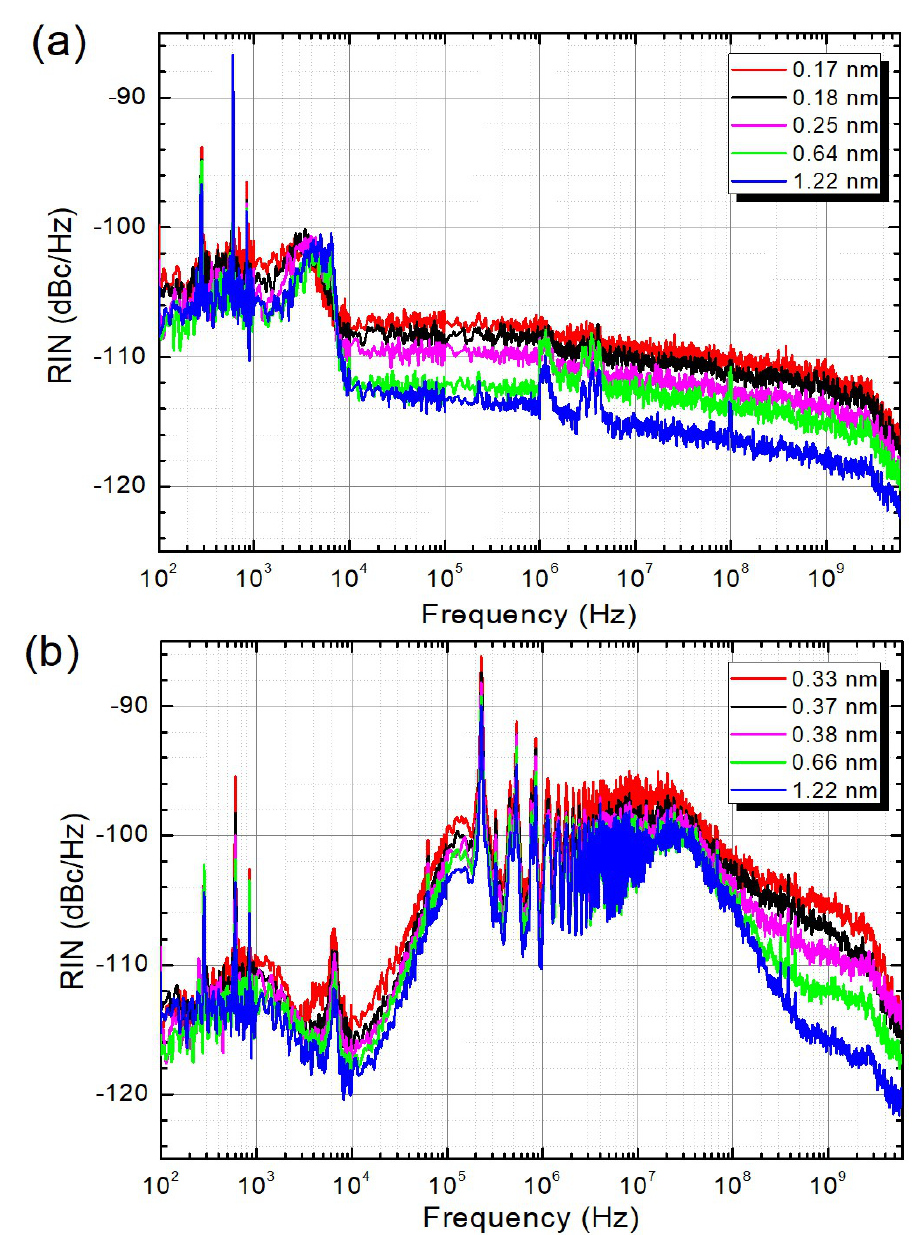
Figure 4. Relative intensity noise of the RDFL at the header ( a ) and end-fiber ( b ) outputs for different linewidths.